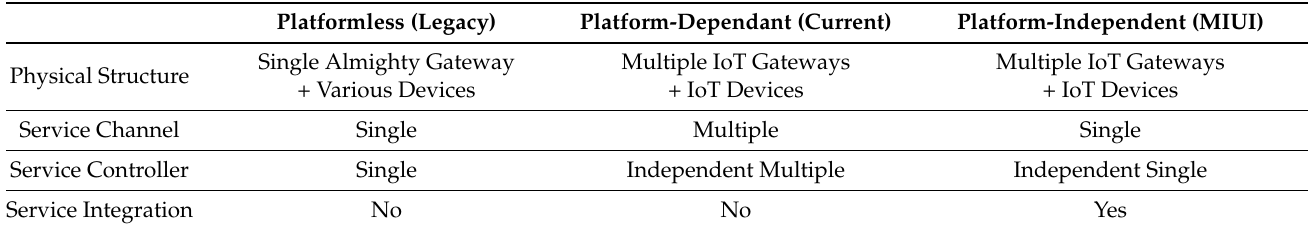
Table 2. Comparison of three IoT service architectures.